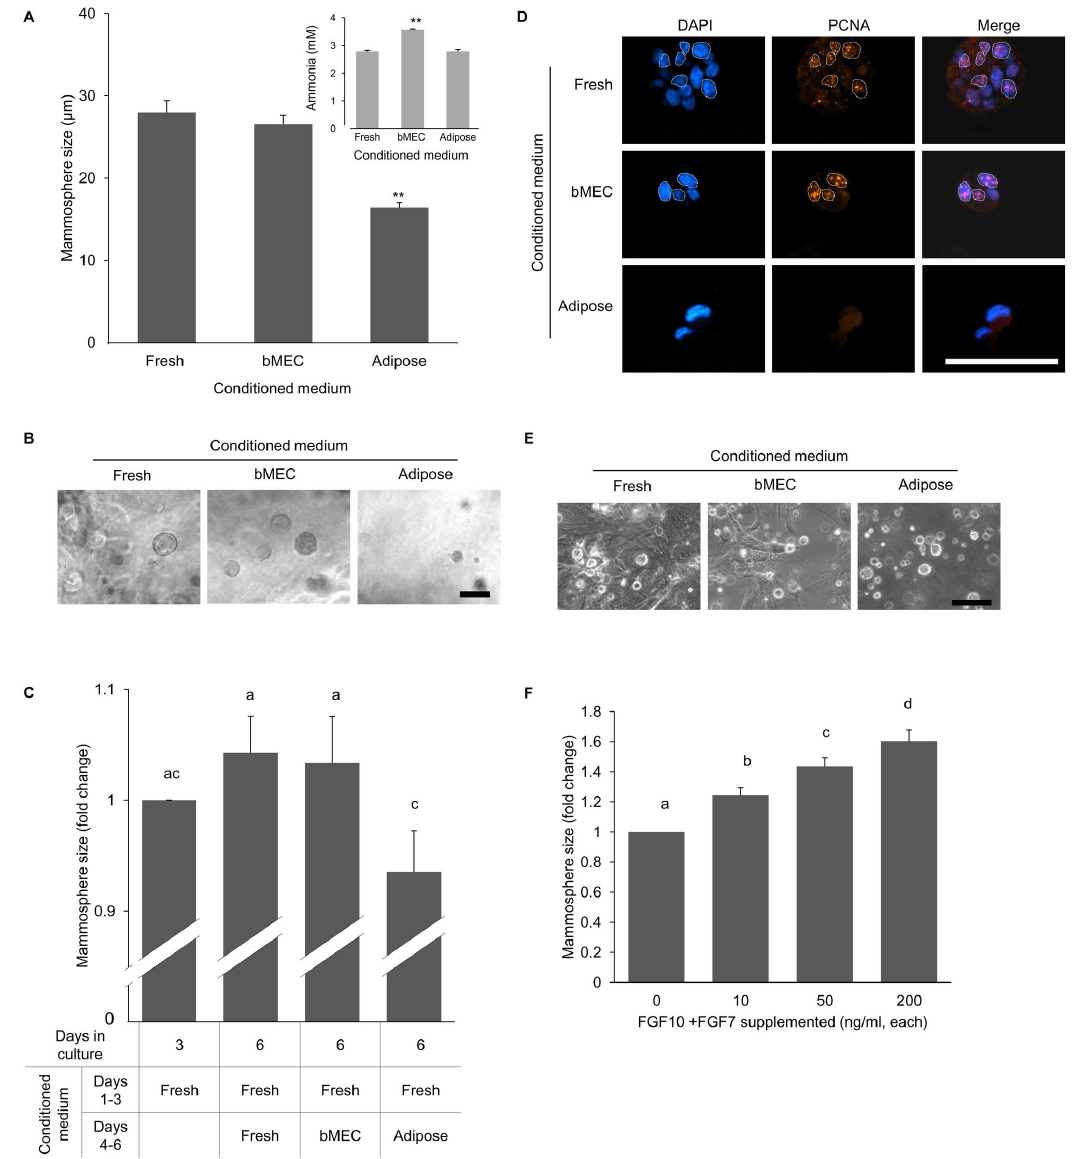
Figure 6. Growth of bovine epithelial mammospheres is suppressed by adipose-conditioned medium and rescued by FGF supplementation. A : Mammospheres formed by bMECs cultured for 3 days within Matrigel are smaller when supplemented with adipose-conditioned medium as compared to bMEC-conditioned or fresh medium. Columns represent average size ± SEM of 28 mammospheres measured in each group. Results of one representative experiment out of three biological replicates are presented. Inset: ammonia levels accumulated in adipose-conditioned, bMEC-conditioned and fresh media. Columns represent average size ± SEM from four analyses of each medium. **Statistically significant difference ( p ≤ 0.01) compared to other columns. B : Light microscopy demonstrating the effect of the culture medium on the size of the developing mammospheres. Bar = 50 µm. C : The effect of the culture medium (fold change) on the size of 3-day-developed mammospheres. Columns represent average size ± SEM of 60 mammospheres measured in each group. Different letters above the columns represent statistically significant differences ( p ≤ 0.05). D : Immunofluorescent staining of PCNA in representative mammospheres formed by bMECs in fresh and conditioned media. PCNA-positive cells are encircled by a white dotted line. Bar = 50 µm. E : Light microscopy demonstrating no effect of adipose- conditioned medium on the size of mammospheres formed by mMECs. Absence of fibroblasts in cultures supplemented with adipose-conditioned medium is noted. Bar = 100 µm. F : FGF7 and FGF10 supplementation to the adipose-conditioned medium induces mammosphere size increase in a dose-dependent manner. Columns represent average size ± SEM of 60 mammospheres measured in each group. Different letters above the columns represent statistically significant differences ( p ≤ 0.05). doi: 10.1371/journal.pone.0068637.g006 PLOS ONE |